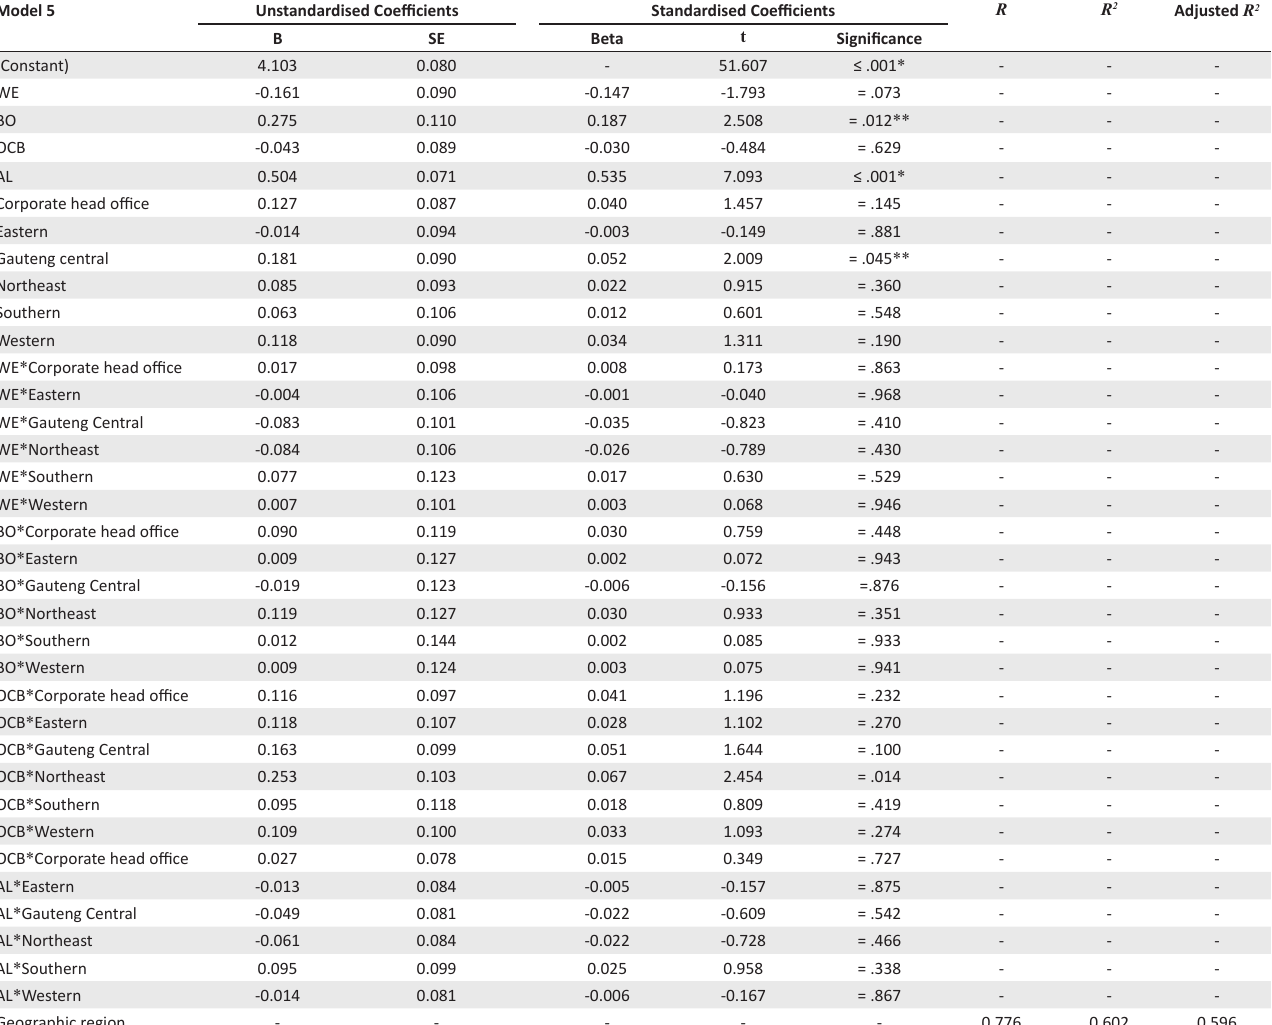
TABLE 8: Moderated multiple regression in terms of geographic